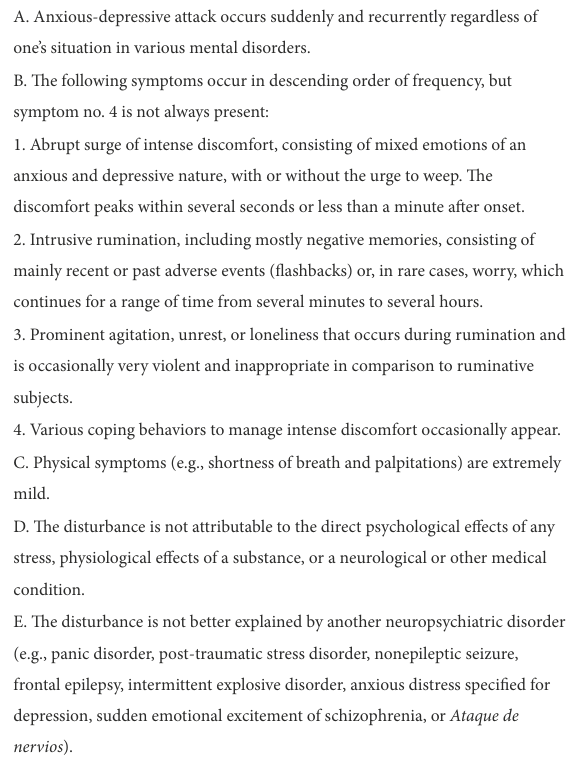
TABLE 1 Diagnostic criteria for anxious-depressive